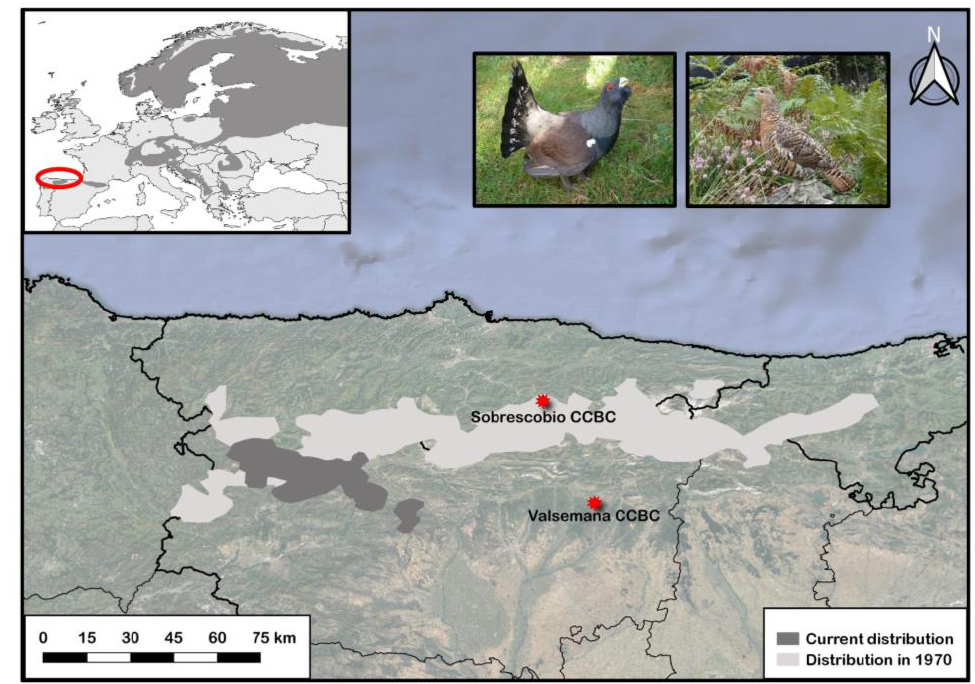
Figure 1. Map showing the Cantabrian capercaillie, Tetrao urogallus cantabricus , distribution range. Approximate distributions for 1970 and 2020, based on [17] are shown in light gray and dark gray, respectively. The locations of the Cantabrian Capercaillie Breeding Centers of Sobrescobio (Sobrescobio CCBC, Asturias province) and Valsemana (Valsemana CCBC, León province) are also shown. The upper-left figure represents the entire distribution range of the species in Europe. Images of male ( left ) and female ( right ) Cantabrian capercaillies can be seen at the top.